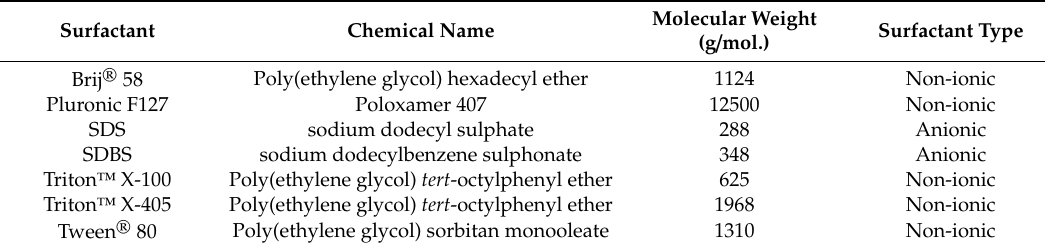
Table 2. List of surfactants used. List reproduced from: [26].